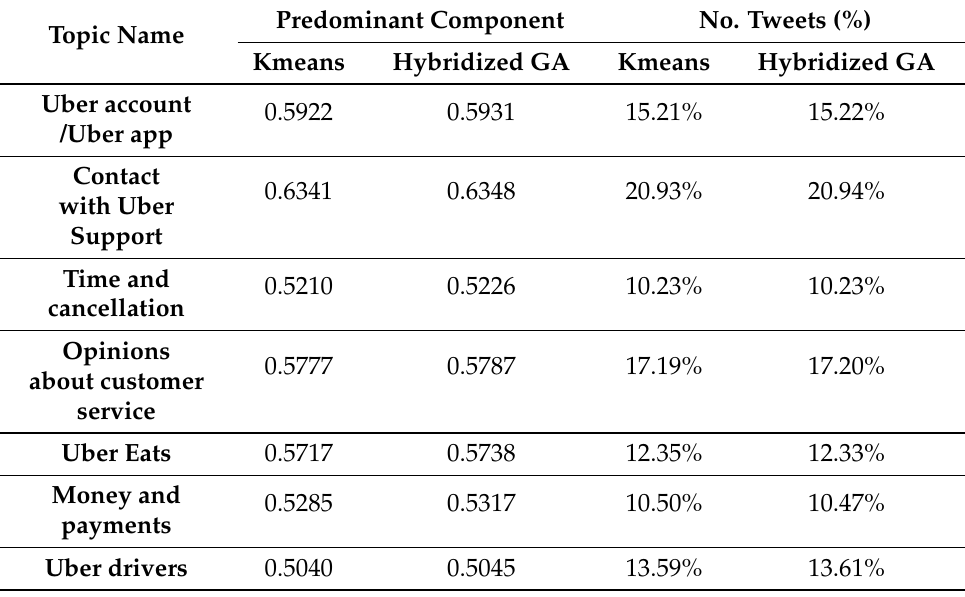
Table 4. Predominant component of each cluster centroid and tweet distribution through the topics.